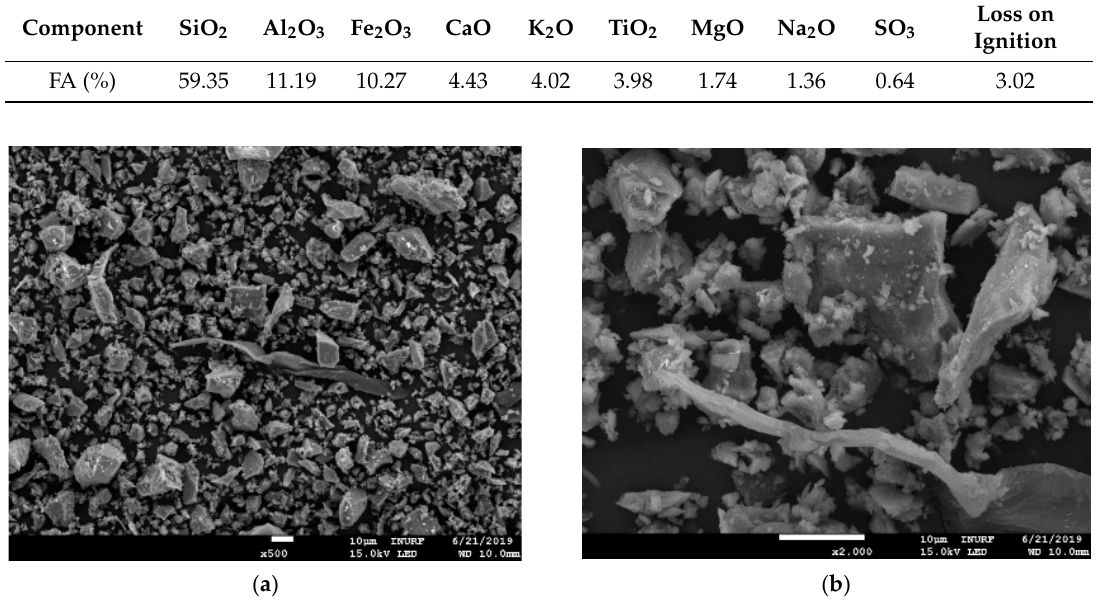
Figure 5. SEM images of WPSA: ( a ) 500×; ( b ) 2000×.